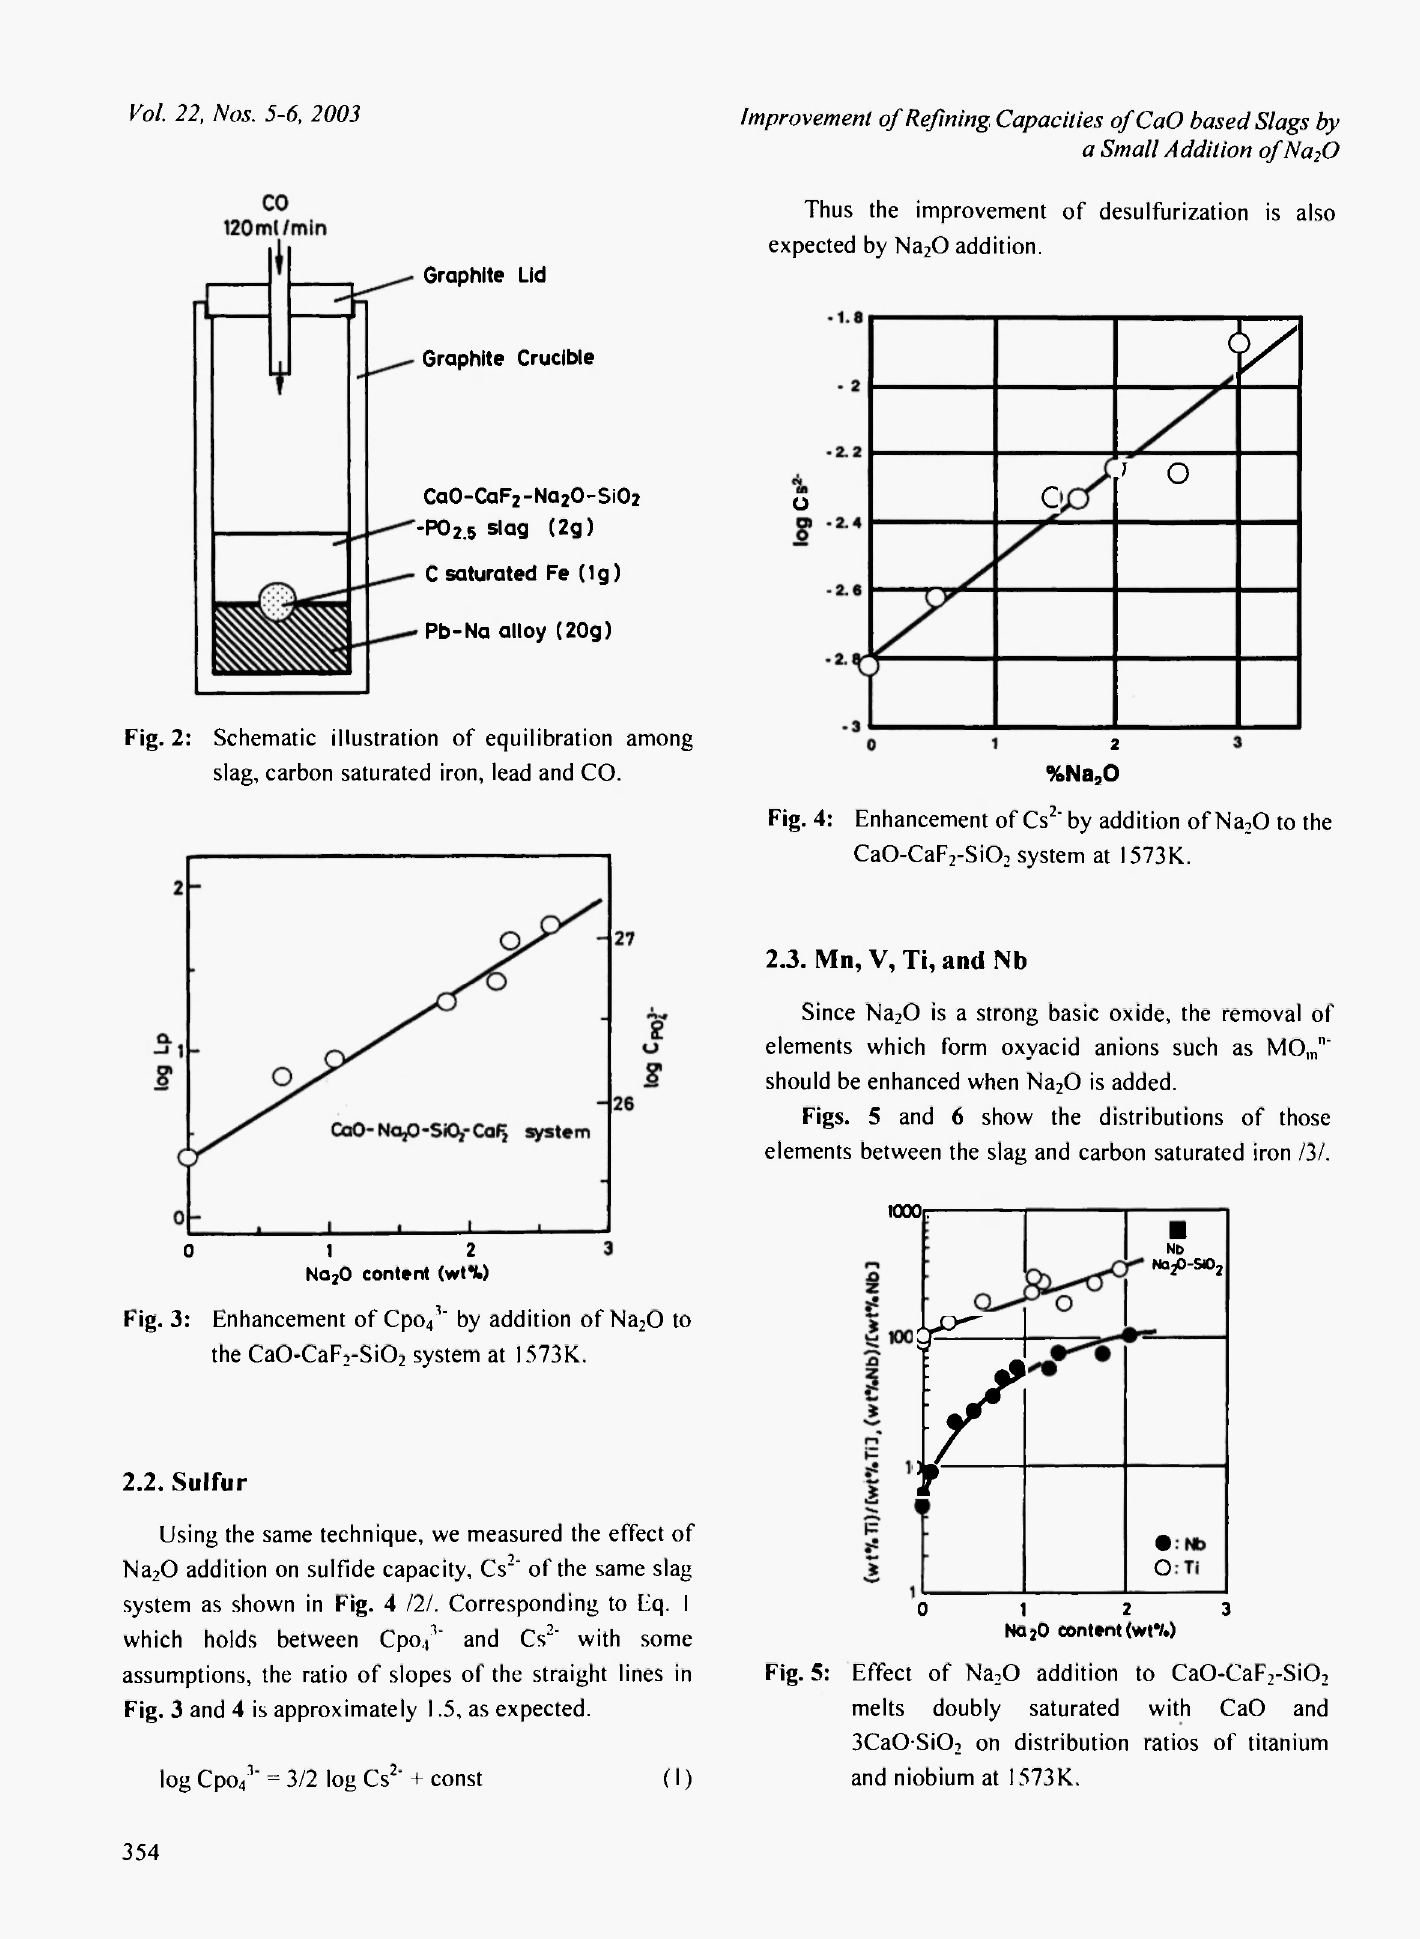
Fig. 3: Enhancement of Cpo 4v by addition of Na 2 0 to the Ca0-CaF 2 -Si0 2 system at 1573K.